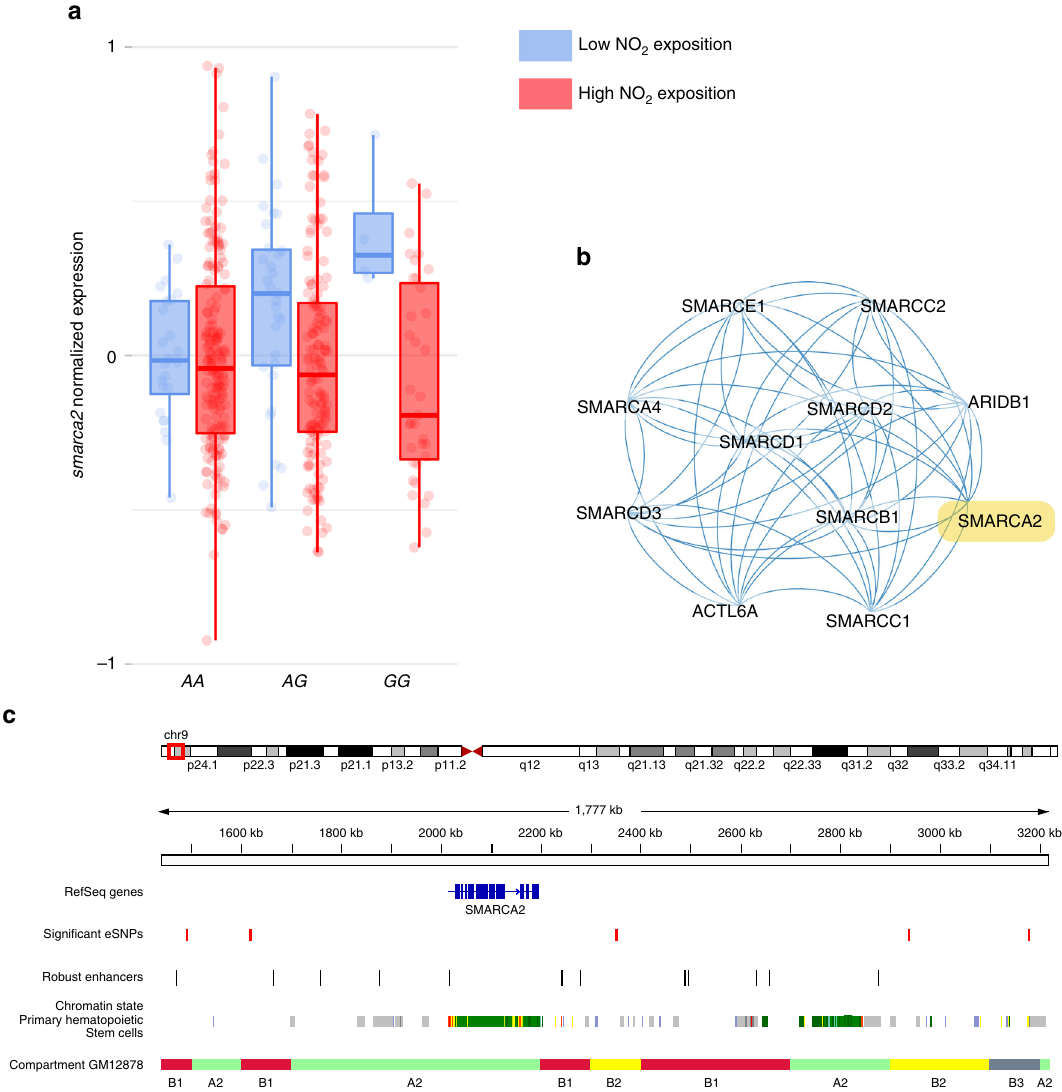
Fig. 4 NO 2 exposure modulates the effect of the top genetic variant rs10156534 on smarca2 expression. a The expression level of smarca2 , an ATP- dependant helicase involved in several cancers, is modulated by the genotype at rs10156534 and NO 2 exposition levels. b SMARCA2 is part of a highly connected gene network, the SNF/SWI complex, which acts to remodel chromatin structure and is required to activate transcription of repressed genes. c Several enhancers around smarca2 are found nearby or at location where eSNPs were signi fi cant for an interaction with pollution. The upper whiskers extend from the third quartile to the largest value no further than 1.5 * inter-quartile range from the third quartile. The lower whiskers extend from the fi rst quartile to the smallest value at most 1.5 * inter-quartile range from the fi rst